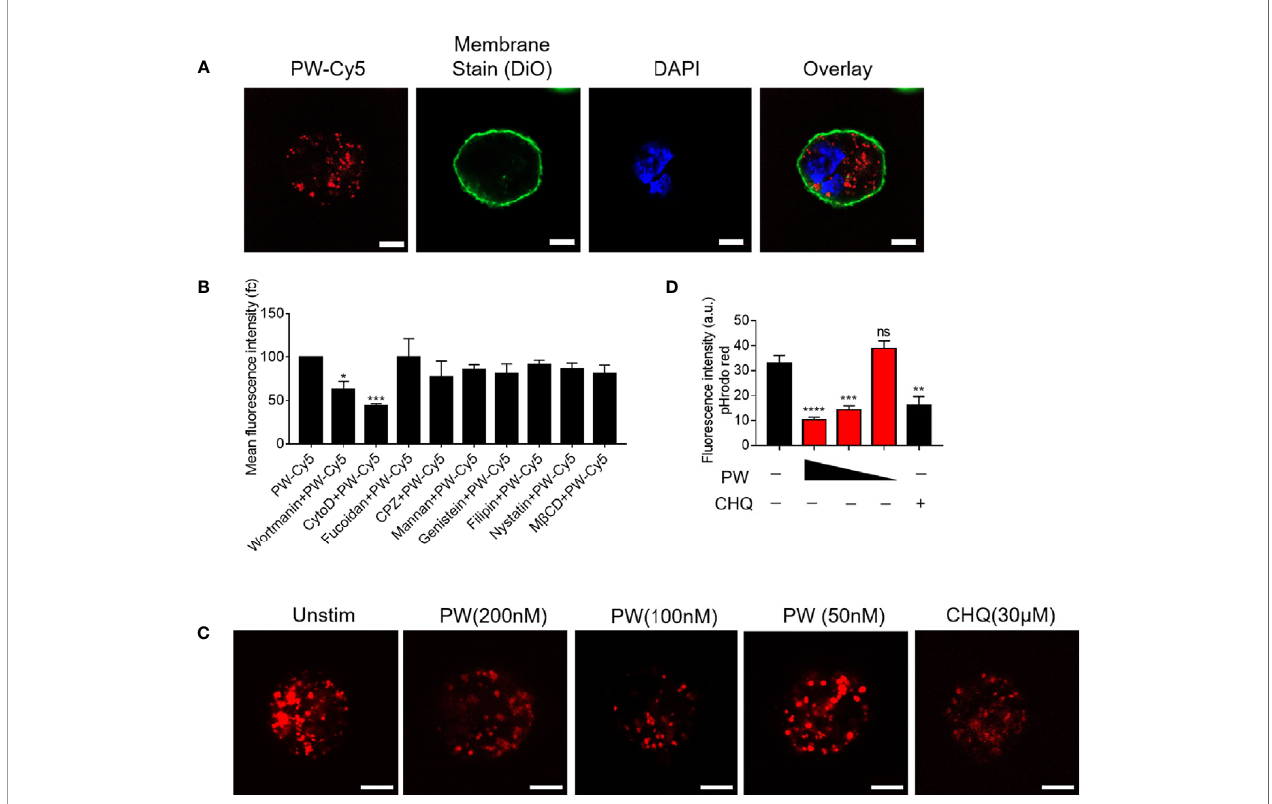
FIGURE 5 | The uptake of PW in THP-1-derived macrophages and the modulation of the endosomal pH. (A) Confocal images of macrophages treated with Cy5 labeled PW (PW-Cy5, red) for 5 h with the cell membrane stained with DiO (green) and the nucleus stained with DAPI (blue). (B) The quantitative analysis of PW-Cy5 in the macrophages with the pre-treatment of various endocytic pathway inhibitors for 5 h in comparison with the no inhibitor control by fl ow cytometry; N ≥ 3. (C) Confocal images of macrophages treated with PW (200, 100 and 50 nM) and the well-known pH modulator chloroquine (CHQ, 30 m M); cells were simultaneously treated with the endosomal pH indicator pHrodo red dextran (10 m g/mL, red); scale bar = 5 m m. (D) Quantitative analysis of the pHrodo red fl uorescence signals as an indicator of endosomal pH; over 30 cells were quanti fi ed from three independent experiments; the fl uorescence intensity is reversely proportional to the pH. *p < 0.05, **p < 0.01, ***p < 0.001, ****p < 0.0001; ns, not signi fi